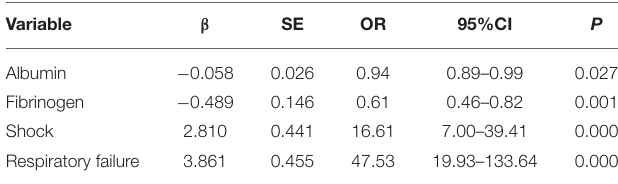
TABLE 6 | Multivariate analysis of patients with streptococcal bloodstream